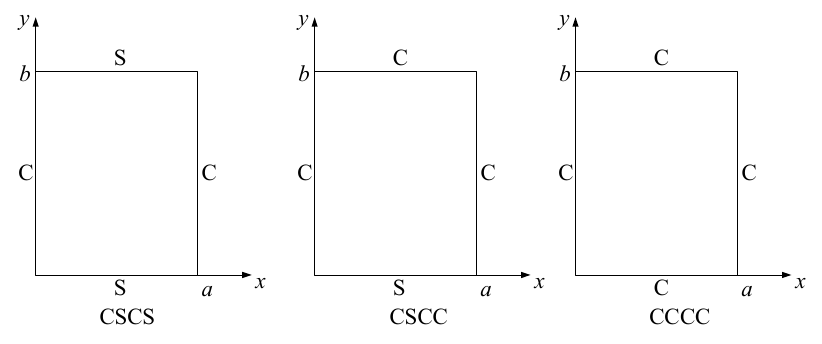
Figure 2. Plates with different boundary conditions. Table 4. The material properties of type-I FGM plate.